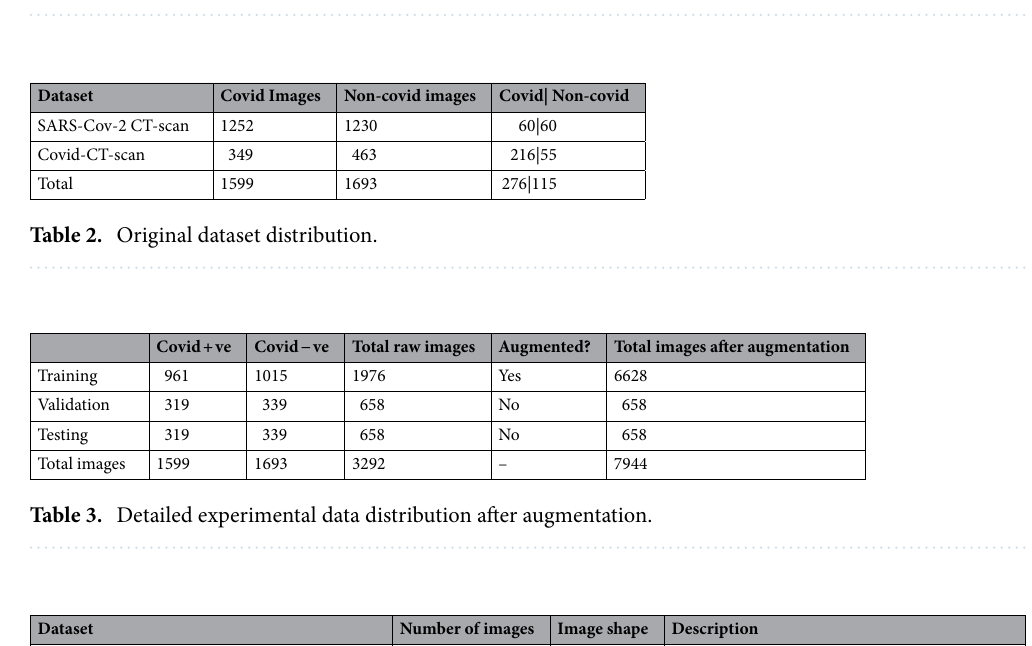
Figure 2. CT images—COVID-19 positive (top) and COVID-19 negative (bottom) from SARS-CoV-2 CT-scan dataset.